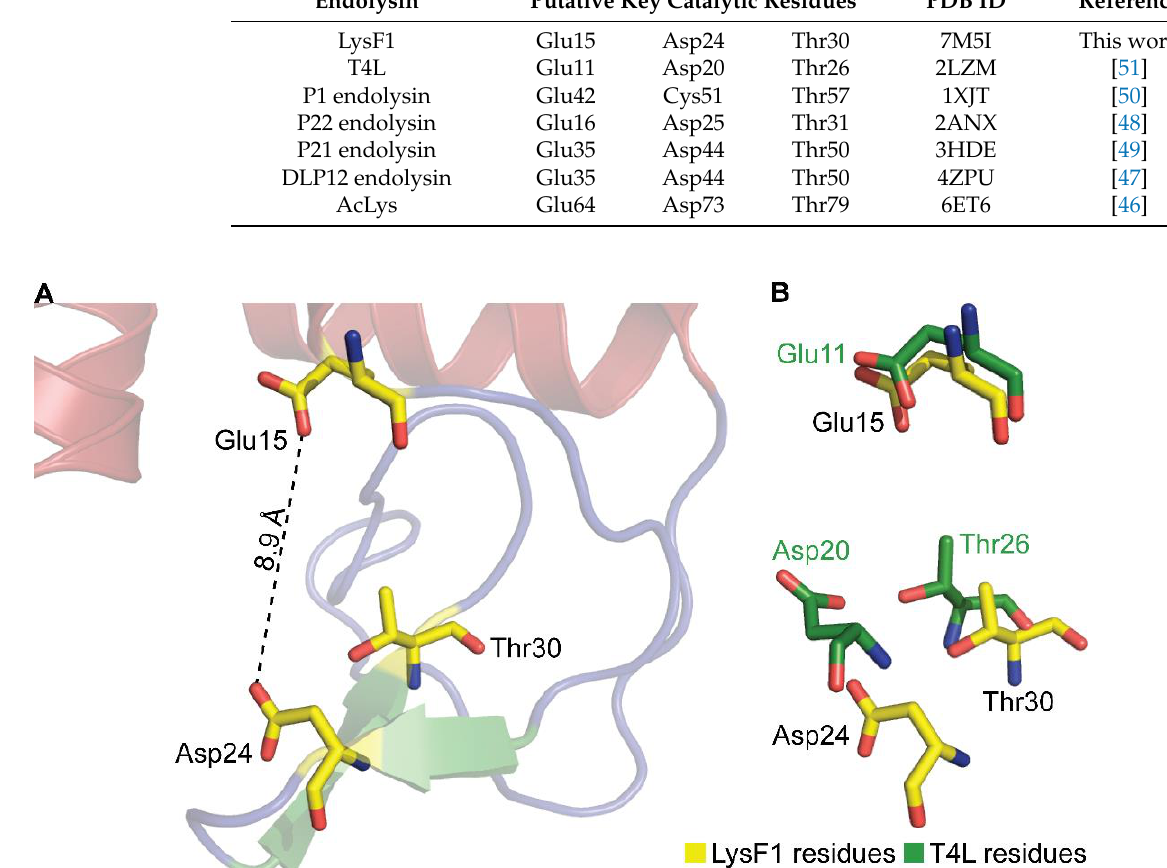
Figure 5. The catalytic site of LysF1. ( A ) The proposed catalytic site of LysF1 identified by sequence similarity which shows that residues Glu15 and Asp24 are positioned at an appropriate distance for the hydrolysis of the peptidoglycan. ( B ) Overlay of the catalytic residues of LysF1 (yellow) with T4L (green) shows the conservation of these key residues, suggesting LysF1 catalyzes the degradation of peptidoglycan using a similar mechanism as T4L.